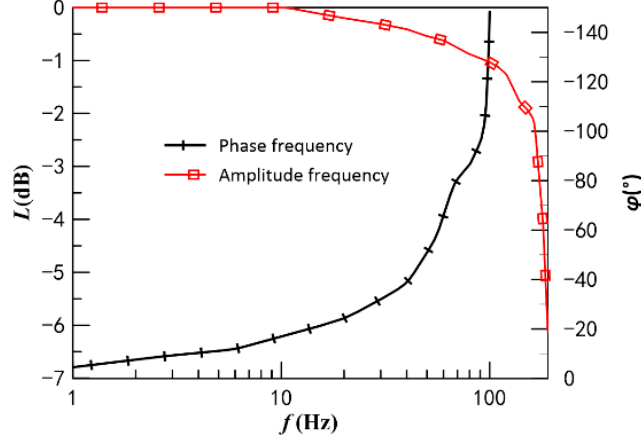
Figure 30. Frequency response characteristics. Figure 31. Frequency response